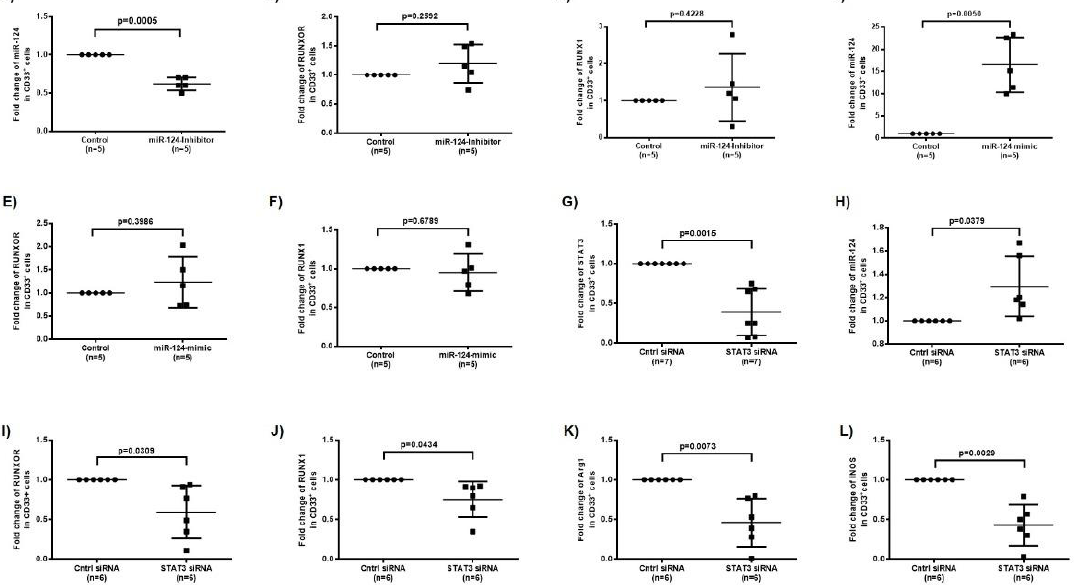
Figure 4. The RUNXOR and RUNX1 expressions correlate with the STAT3–miR124 axis in MDSCs during HCV infection. ( A – C ) Silencing miR-124 in HS-CD33 + cells significantly reduces the level of miR-124 but only slightly increases RUNXOR and RUNX1 expressions. ( D – F ) Overexpression of miR-124 in HCV-CD33 + cells significantly increases miR-124 levels but does not affect RUNXOR and RUNX1 expressions. ( G – L ) Silencing STAT3 expression in HCV-CD33 + cells significantly decreases STAT3 level, increases miR-124 expression, and inhibits RUNXOR, RUNX1, Arg1, and iNOS mRNA expressions ( I – L ).